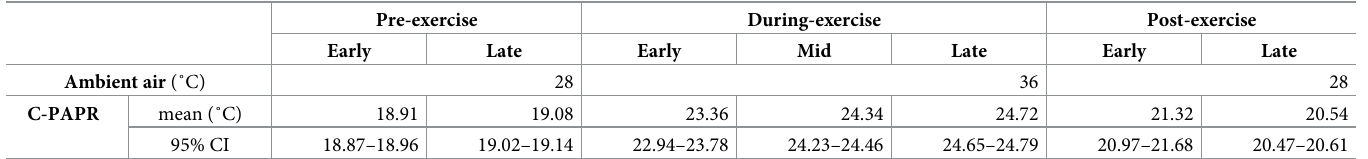
Table 1. Inhalation temperature.